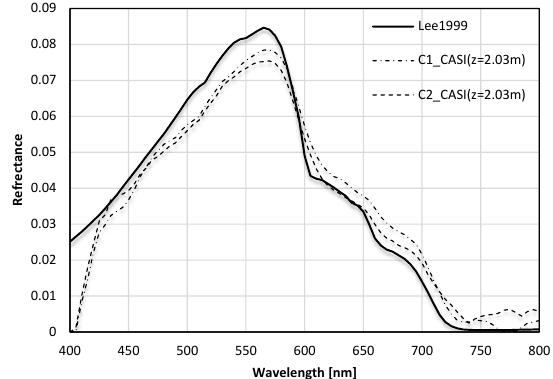
Figure 3. Sand spectral simulation at 2.03 m water depth Figure 4 indicates R rs of seagrass target at 1.53 m water depth. The parameters of the variables are defined as [chl-a] in 0.8, P in 0.06, X in 0.08, and H in 1.0.